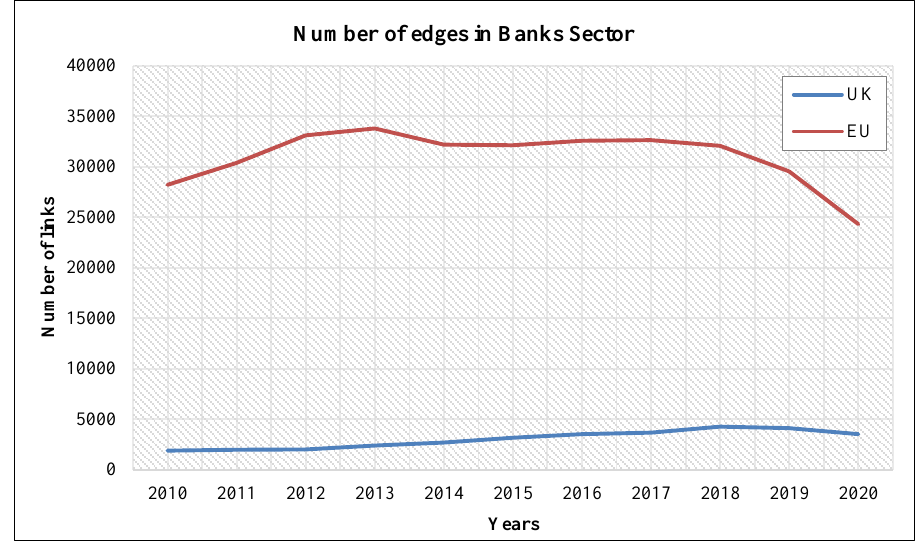
Figure 7. Comparison Analysis for the Number of Edges in the Bank